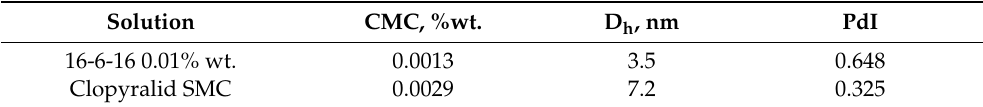
Table 3. Properties of 16-6-16 aqueous solutions in the absence and presence of clopyralid: CMC, hydrodynamic diameter (D h , nm) of particles, and polydispersity index (PdI).